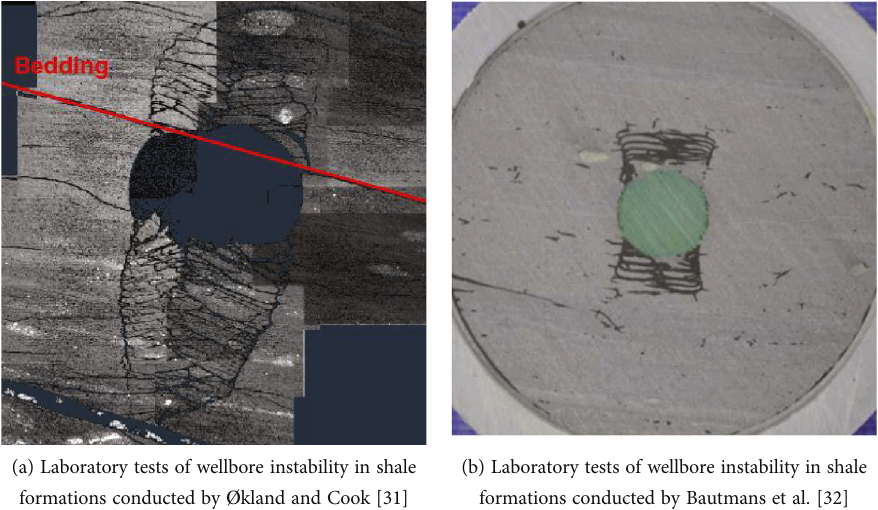
Figure 8: Collapse mechanism in a thick-walled cylinder test performed with well oriented parallel to